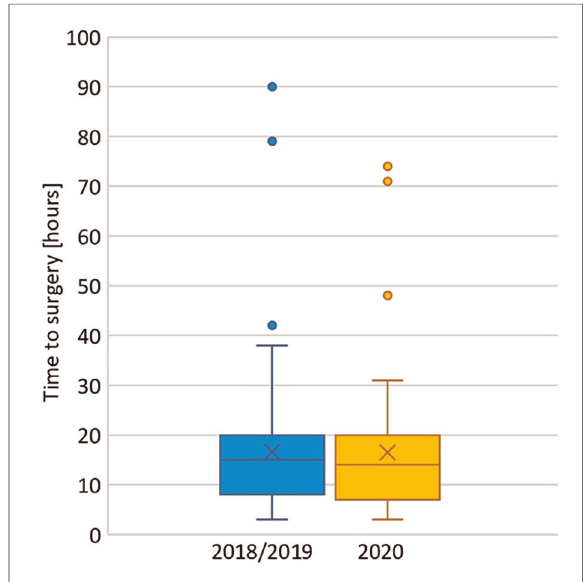
FIGURE 6 Time from admission at the Hospital of Neuchâtel to surgery in 2018/2019 and 2020.